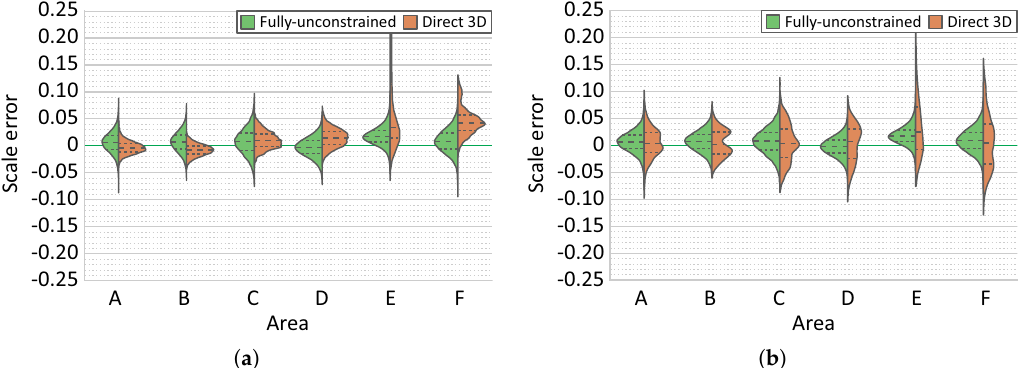
Figure 29. Comparison of estimated scale errors computed with fully-unconstrained and simplistic direct 3D method using ( a ) only nearly-parallel laser pairs and ( b ) all laser pairs.